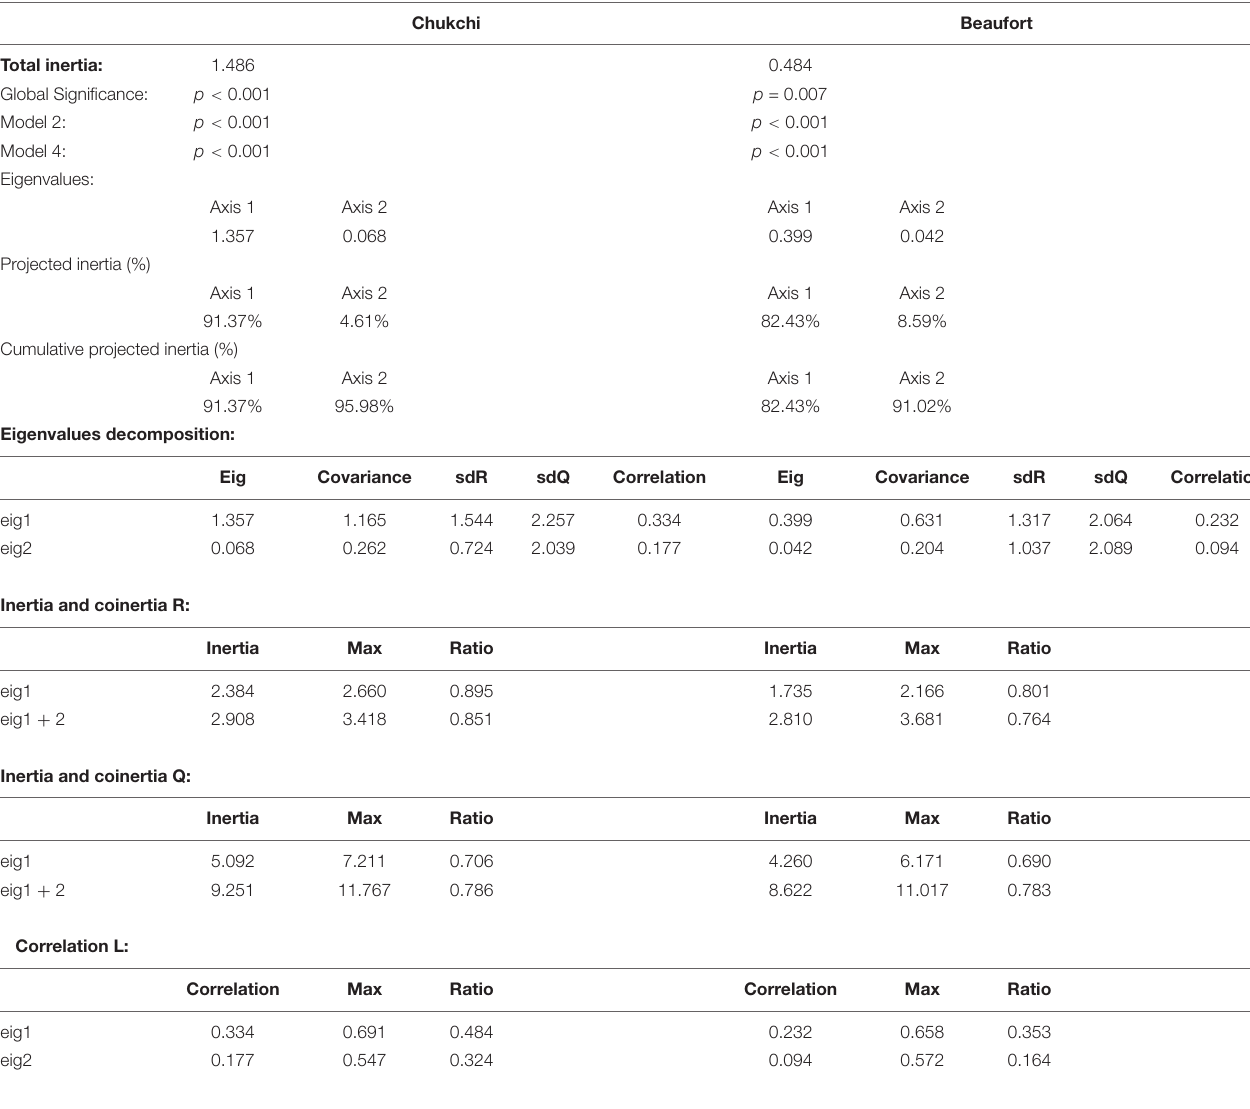
TABLE 2 | Summary of the RLQ analysis for the Chukchi Sea (left) and Beaufort Sea (right).